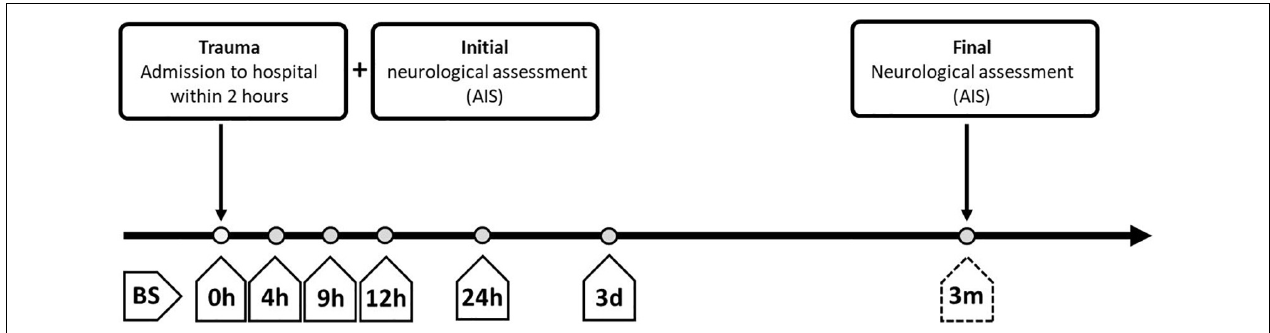
FIGURE 2 | Overview of standardized blood sampling and neurological assessment protocols for patients with severe traumatic injuries. The study enrolled patients who were administered to the hospital within 2 h after the traumatic injury. Blood samples (BS) were collected at different time points after admission,